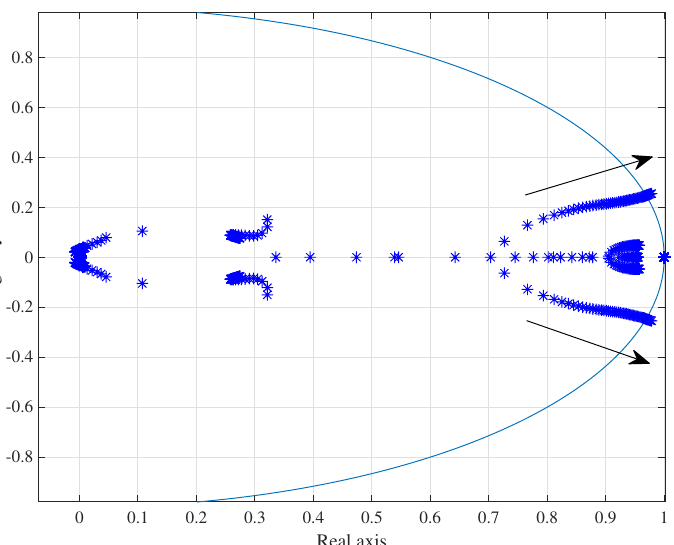
Figure 9. Floquet multipliers and system frequency result from the variation K q = 0.002, K p = [ 3 × 10 − 5 : 8.3 × 10 − 4